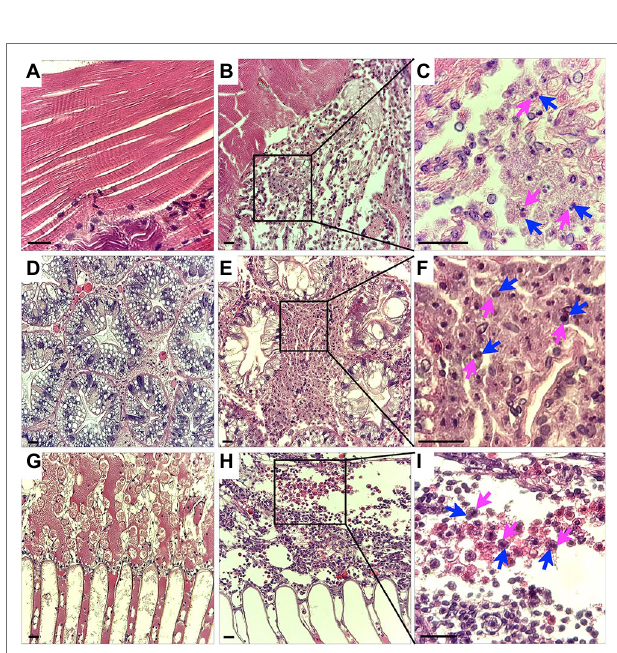
FIGURE 7 | Histology of CsTLV1 and CsTLV2 infections in muscle, gill, and hepatopancreas of Callinectes sapidus . (A,D,G) Muscle, hepatopancreas, and gill of uninfected crabs; (B,E,H) Muscle, hepatopancreas, and gill of CsTLV1 and CsTLV2 infected blue crabs; (C,F,I) Magnified view of boxed area in (B,E,H) , respectively. Infected hemocytes in muscle, hepatopancreases, and gill often had pyknotic or karyopyknotic nuclei (magenta arrows) as well as opaque, slightly eosinophilic intracytoplasmic inclusion bodies (blue arrows). Scale bar, 25 μ m.